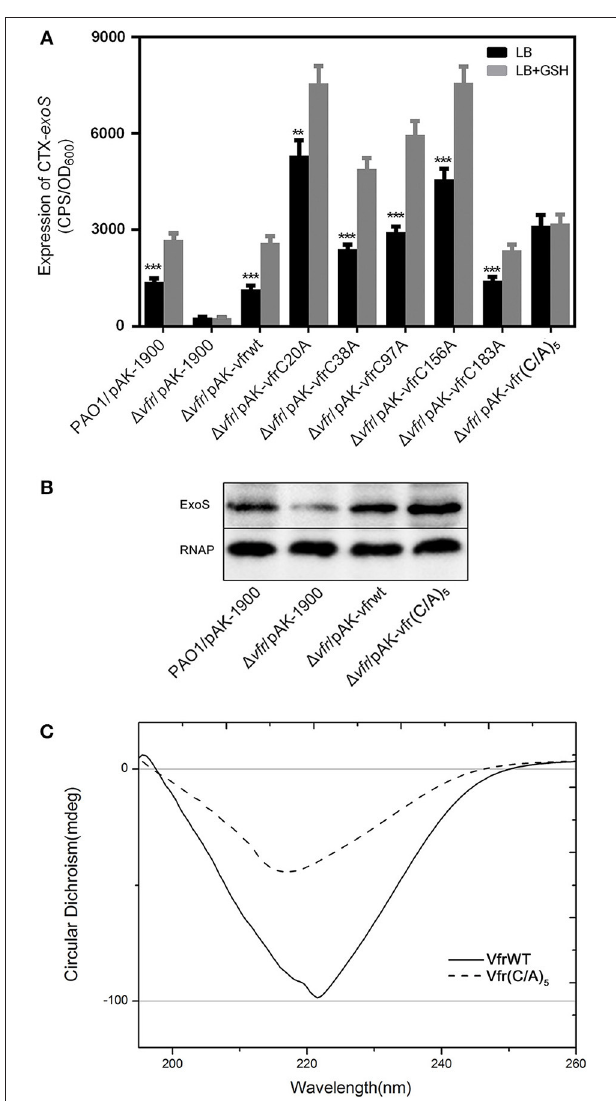
FIGURE 5 | Cysteine residues in Vfr involved in signal transmission of glutathione. All P. aeruginosa strains carrying exoS - lux plasmids was grown under T3SS-inducing conditions (5mM EGTA, 20mM MgCl 2 ) with or without 10mM GSH. (A) Effect of cysteine-to-alanine mutation at positions 20, 38, 97, 156, and 183 of recombinant Vfr on the expression of exoS . (B) Secretion of ExoS in the indicated strains. ** P < 0.01, *** P < 0.001 compared to PAO1 by Student’s t -test. (C) Circular dichroism (CD) spectroscopy analysis of the secondary structure of Vfr and the Vfr (C/A) 5